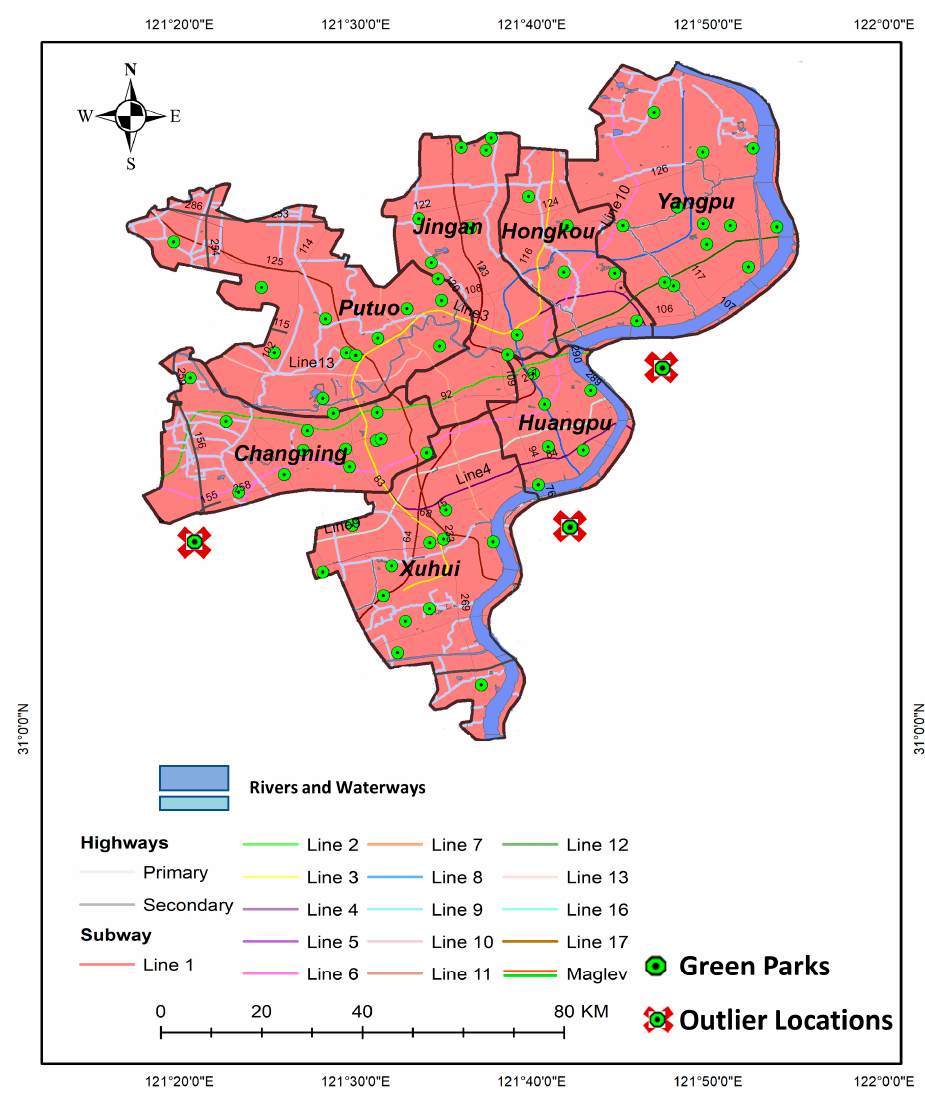
Figure 5. Parks and outlier locations in the study